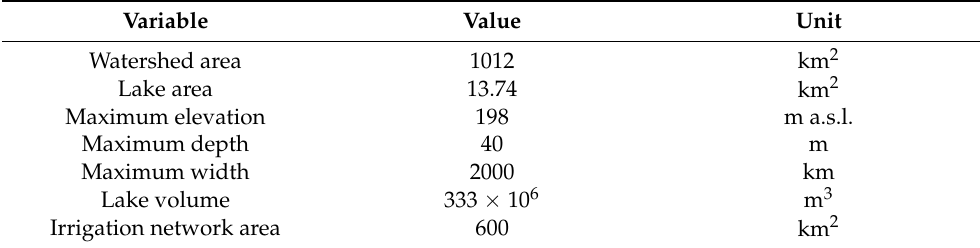
Table 1. Morphometric features of Lake